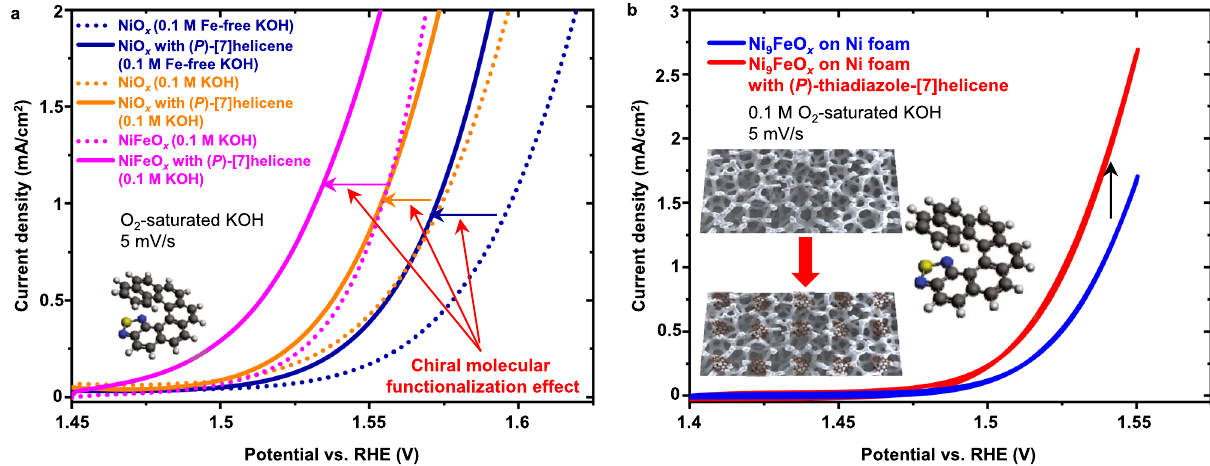
Fig. 2 Comparison of chiral molecule effect with Fe-doping effect. a Chiral molecular functionalization enhancement on NiO x islands in Fe-free, NiO x islands in KOH (unpuri fi ed) and NiFeO x islands in KOH (unpuri fi ed). b Chiral molecular functionalization enhancement at Ni 9 FeO x deposited on Ni foam. Source data are provided as a Source Data fi